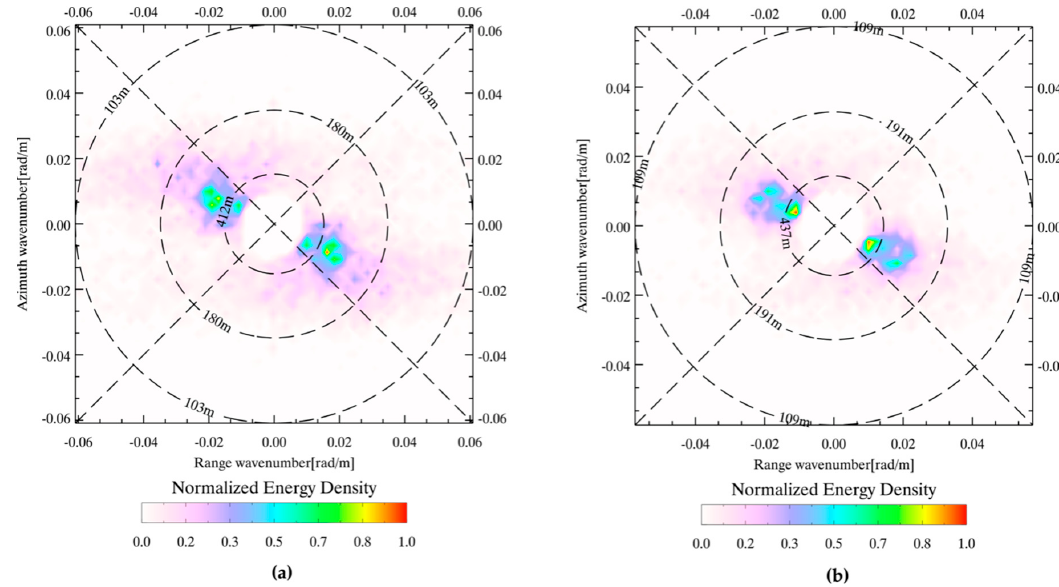
Figure 3. Two-dimensional SAR spectra by using FFT method ( a ) corresponding to sub-scene of Figure 2a; and ( b ) corresponding to sub-scene of Figure 2b.